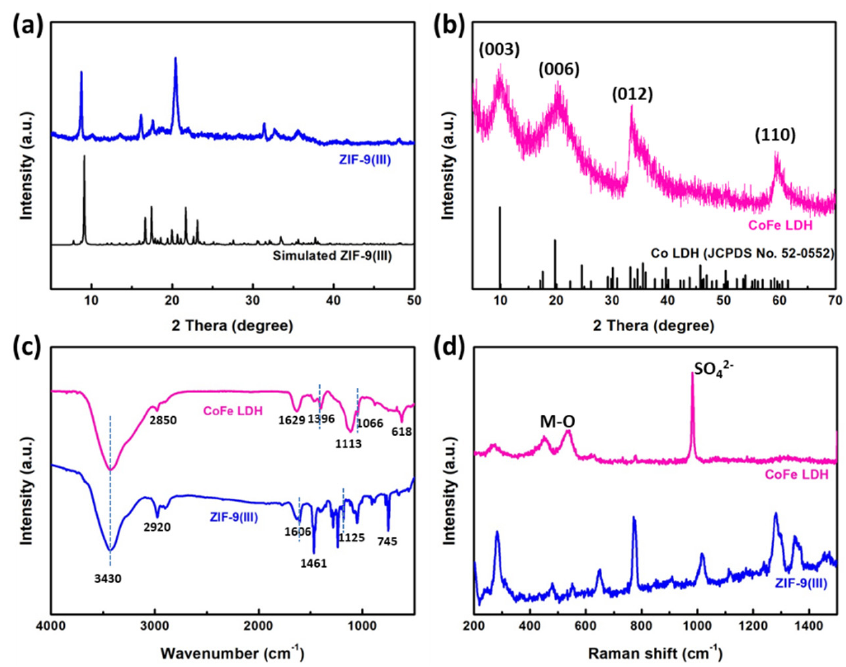
Figure 2. XRD patterns of ( a ) ZIF-9(III), simulated ZIF-9(III) and ( b ) CoFe LDH, ( c ) FTIR spectrum, and ( d ) Raman spectroscopy of ZIF-9(III) and CoFe